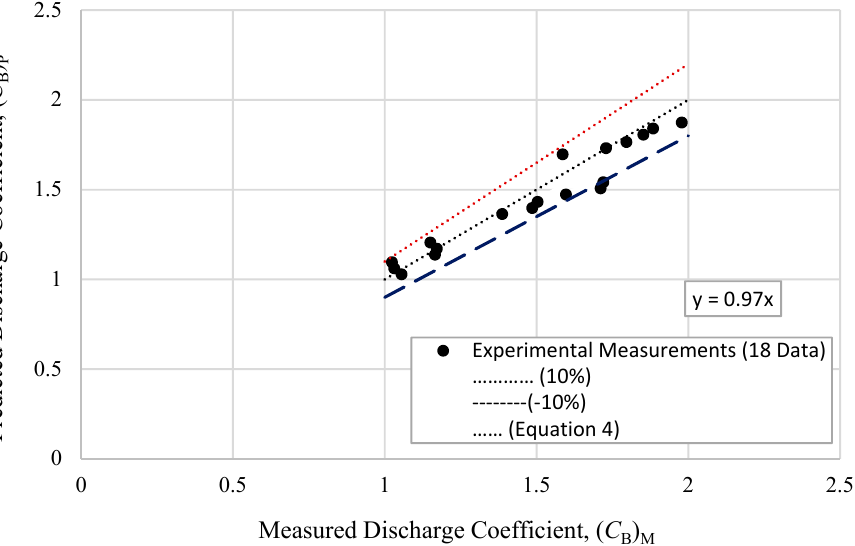
Figure 23. Measured vs. Calculated Discharge Coefficients (C B ) for all models.